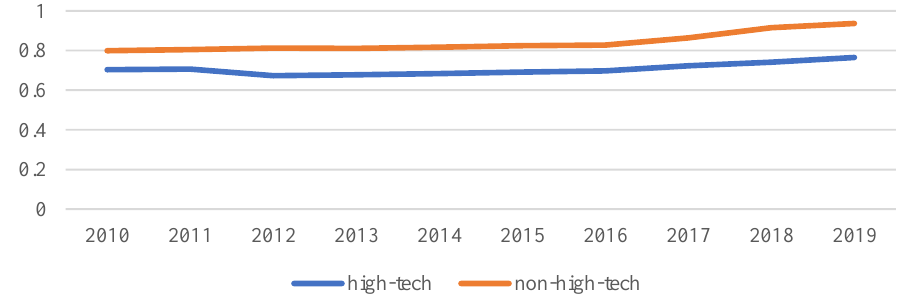
Figure 9. The trends of high-tech and non-high-tech MAGG levels during the years 2010 – 2019.